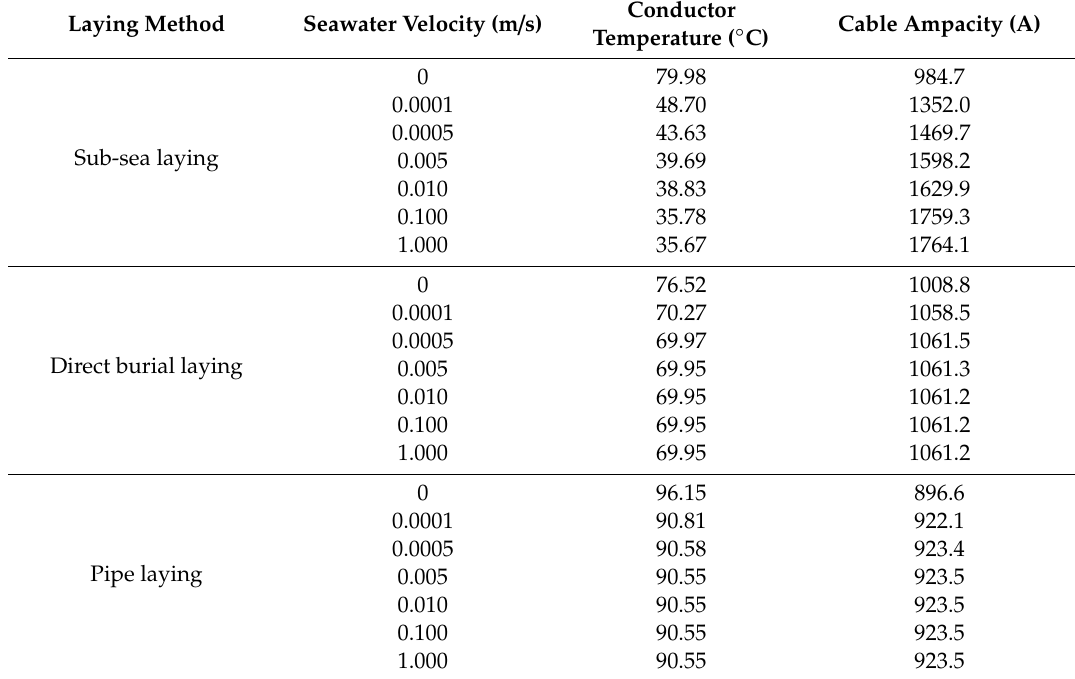
Table 2. Conductor temperature and ampacity of submarine cable under di ff erent seawater